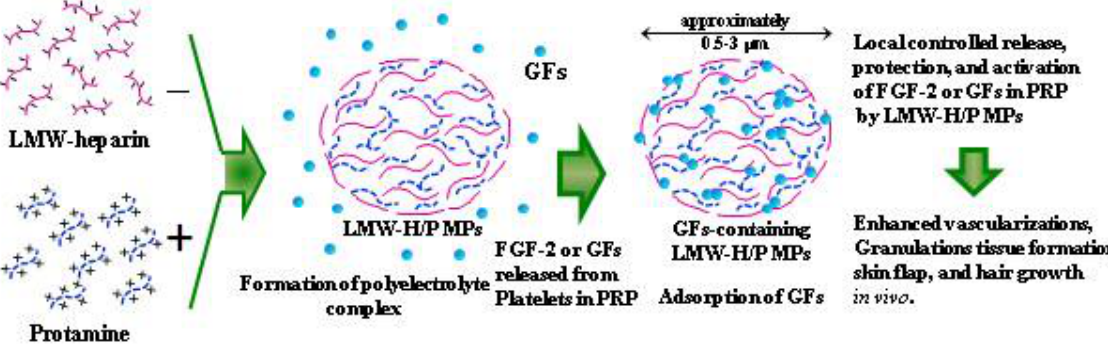
Figure 3. Mechanism on formation and function of GFs-containing LMW-H/P MPs.